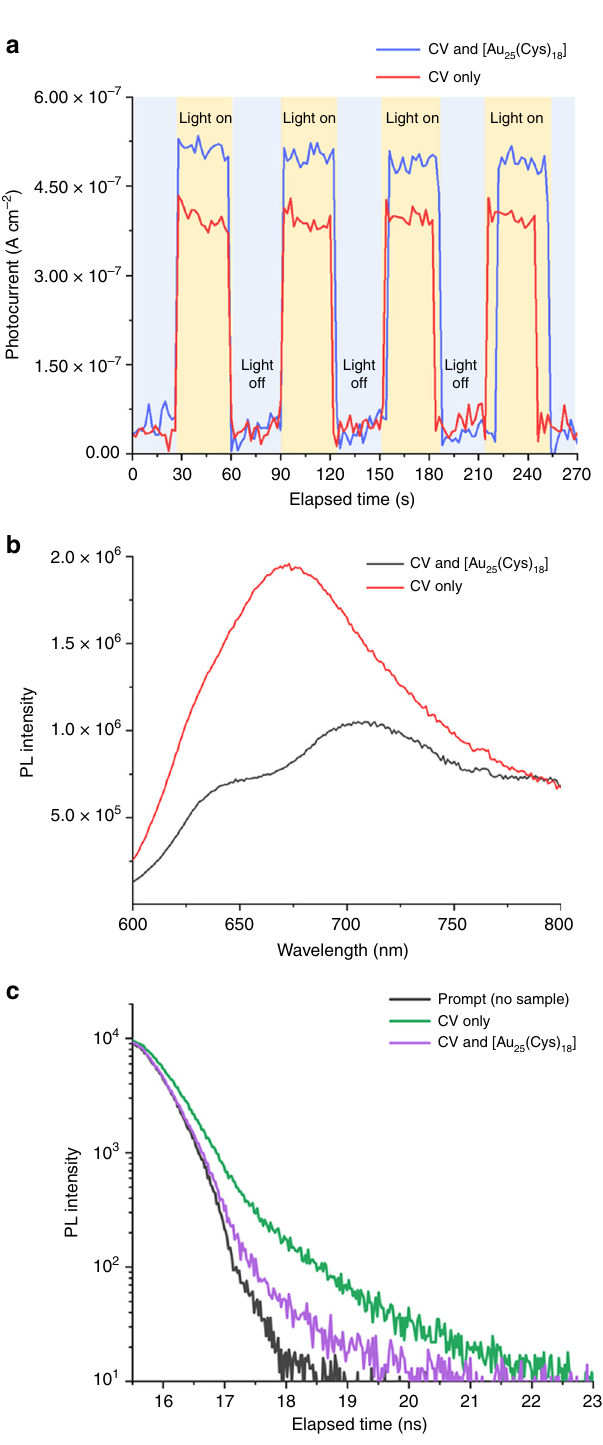
Fig. 5 Photoreaction characterisation of CV only and CV&[Au 25 (Cys) 18 ]. a Transient photocurrent responses for CV only and CV&[Au 25 (Cys) 18 ] under white light. CV indicates crystal violet. b Photoluminescence (PL) spectra of CV only and CV&[Au 25 (Cys) 18 ] in wavelength of 600 to 800 nm ( λ Ex = 574 nm). c Time-resolved photoluminescence (PL) decay of CV only and CV&[Au 25 (Cys) 18 ] ( λ Ex = 574 nm, λ Em = 650 respectively (Supplementary Fig. 6a and d) and homo band max- imum energies ( E HBM ) of CV and [Au 25 (Cys) 18 ] were 1.6 and 1.07 eV, respectively (Supplementary Fig. 6b, e). A difference of binding energy between N 1s core level (CL) and homo band was